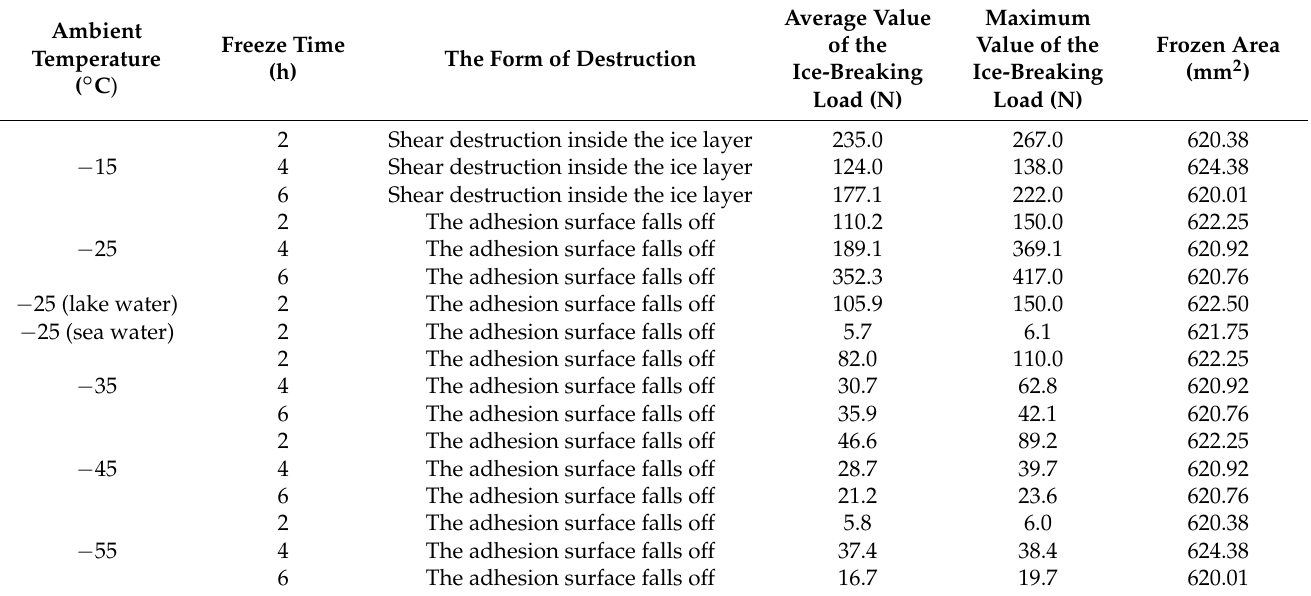
Table 5. Ice-breaking load of AL-Ice-AL specimens in shear tensile test.